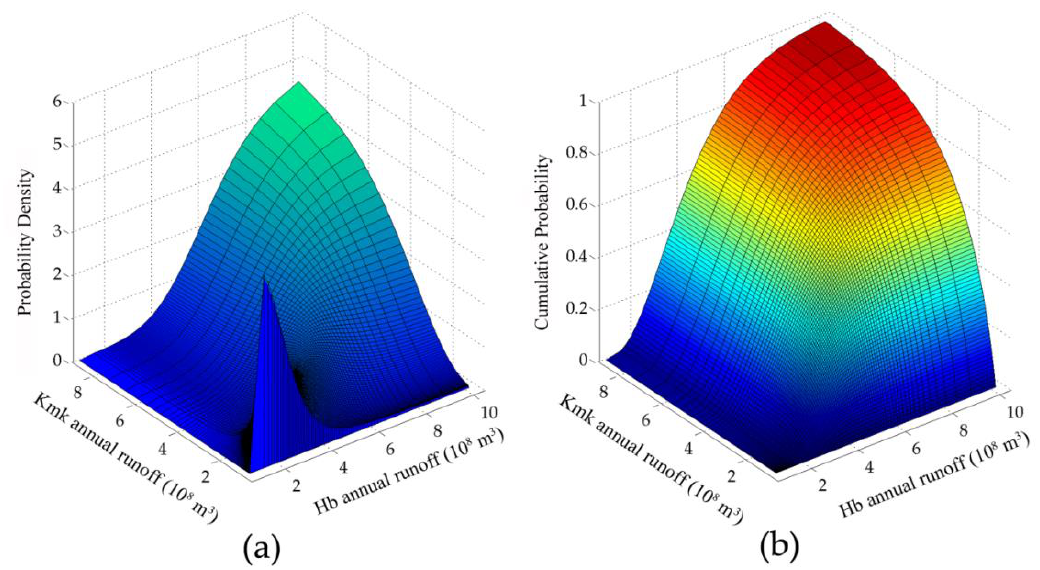
Figure 6. Joint distribution in the case of Frank copula. ( a ) Probability density distribution; ( b ) Cumulative probability distribution.